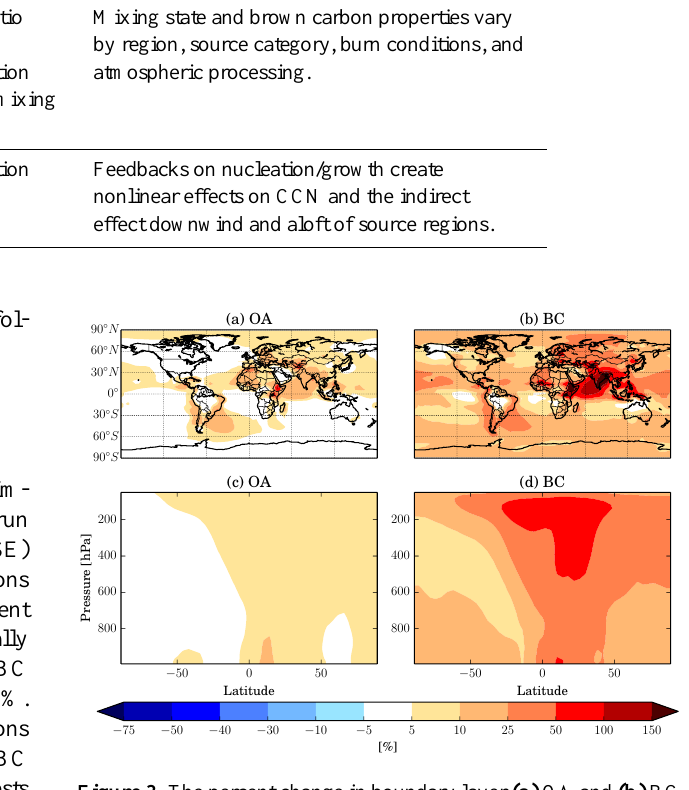
Figure 3. The percent change in boundary layer (a) OA and (b) BC mass and ( c and d ) zonally averaged with pressure for the BASE– NOBIOF